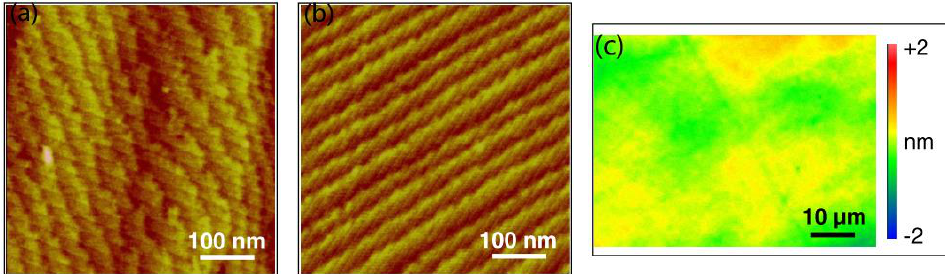
Figure 16. AFM images of the surface processed by PAP using ( a ) Al 2 O 3 abrasives, ( b ) CeO 2 abrasives; ( c ) SWLI image of the surface processed by PAP using CeO 2 abrasives [39].